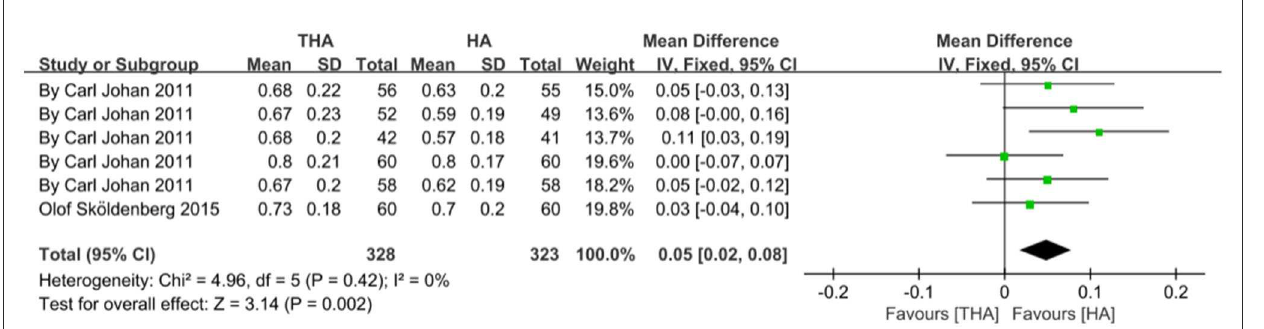
FIGURE4 Forest plot depicting the relationship of health-related quality of life between THA and